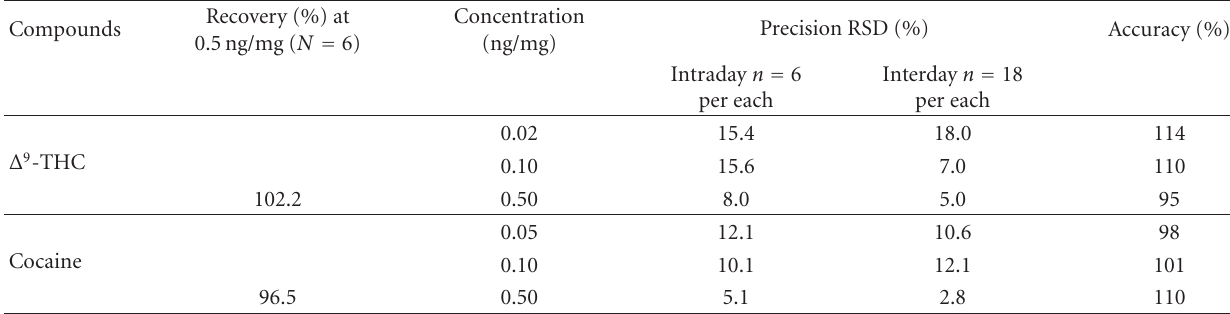
Table 1: Summary of assay validation results.